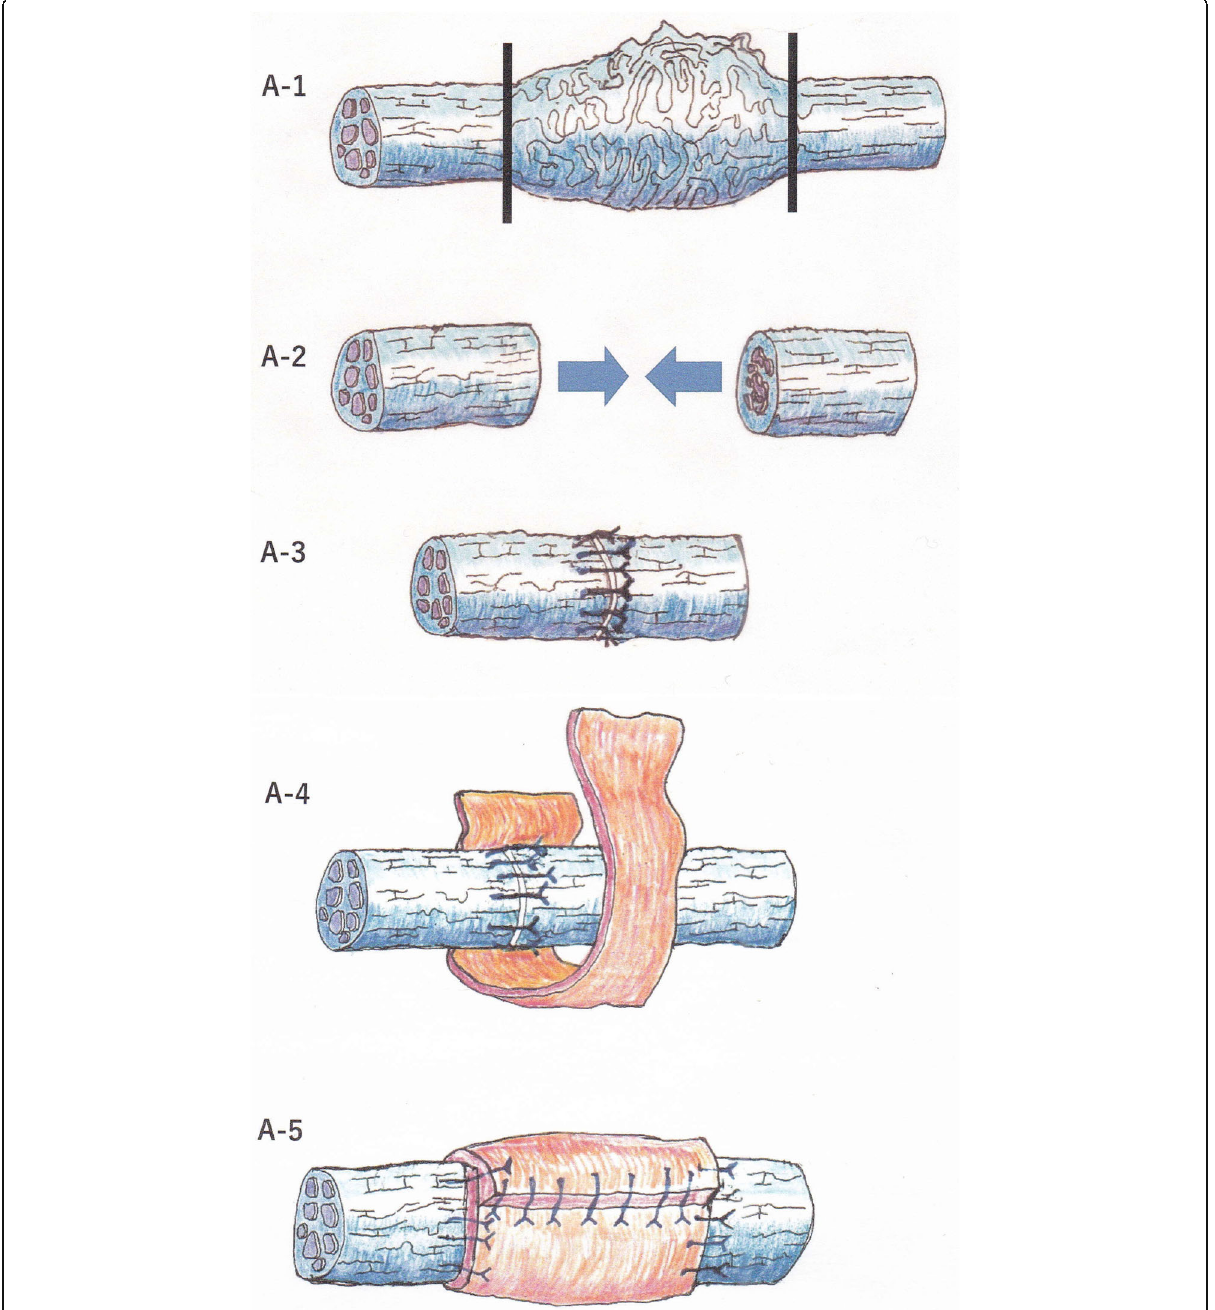
Fig. 1 Direct perineurial repair with a vein graft cuff. A-1:Nerve stump preparation. Neuroma resection at the clinical margin of the neuroma fails to complete nerve preparation. A-2:Remove as much scar tissue as possible from the torn nerve, mobilized and trimmed to a point where the fascicles could be identified in a microsurgical field. A-3:Direct end-to-end epineural nerve suture without tension was performed. A-4: A segment of the external jugular vein was tagged for use as a cuff to cover the sutured nerve. The autogenous vein graft was split longitudinally and turned inside-out. A-5: The vein graft encased the sutured site, and attached to the epineural membrane with 8-0 nylon on each